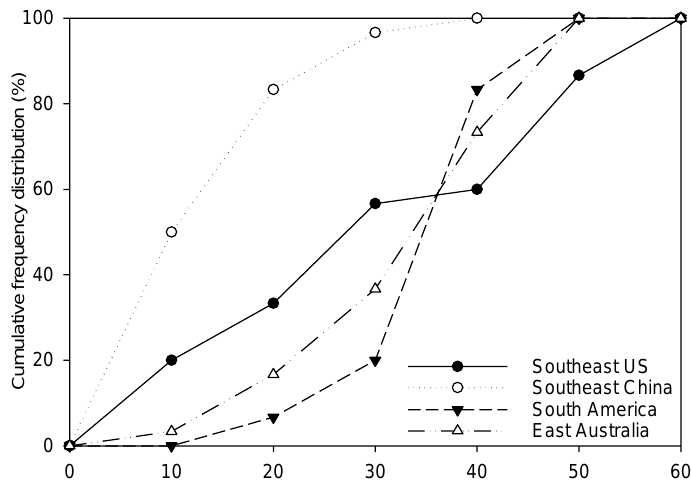
Figure 3. Cumulative frequency of annual number of days with maximum temperature ≥32 °C from 1981 to 2010. Temperature for reference locations for humid subtropical regions in the southeast U.S., southeast China, South America, and east Australia [39] .